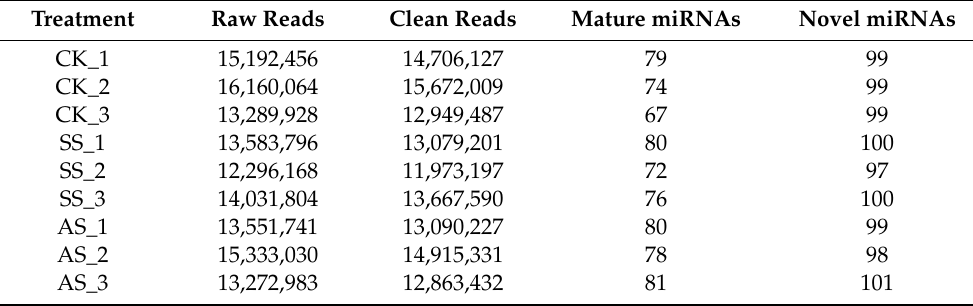
Table 2. Summary of small RNA (sRNA) sequencing datasets.